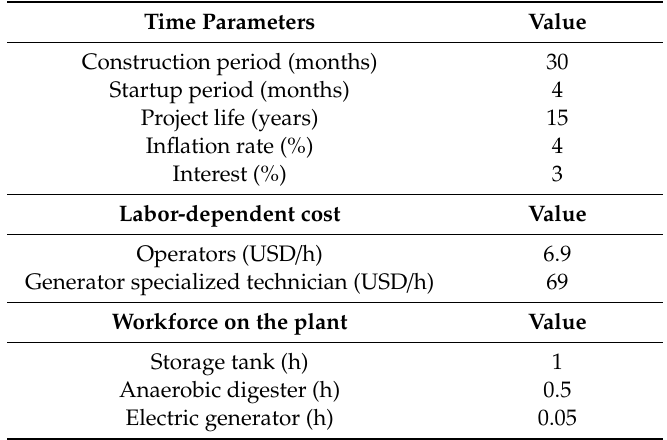
Table 2. Parameters used for the economic evaluation of a sugarcane-based vinasse-fed AD plant.